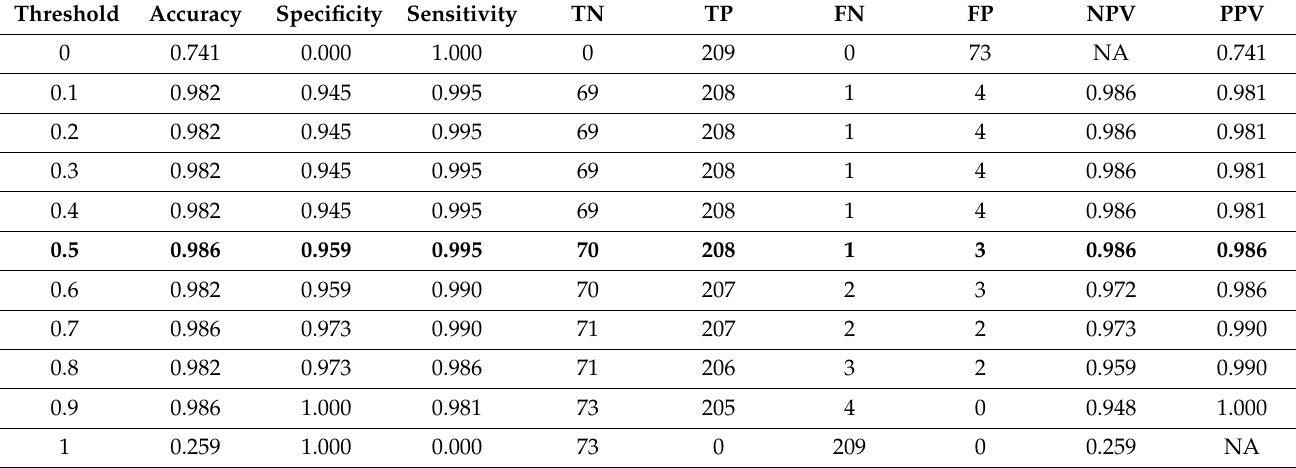
Table 3. Performance of the LASSO model on the test dataset